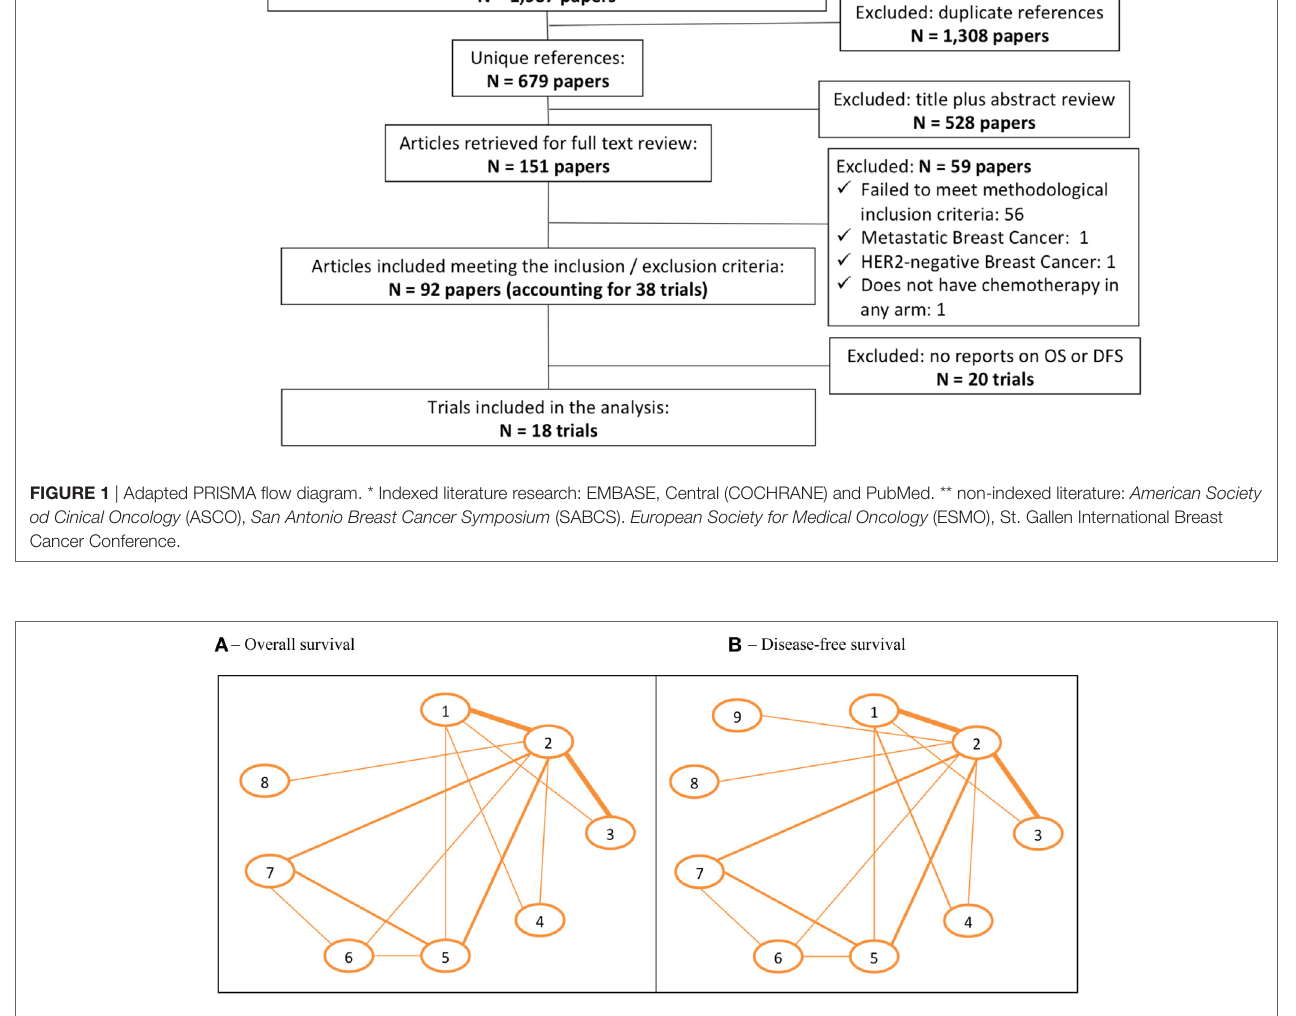
FiGURe 2 | Networks for overall survival (OS) and disease-free survival (DFS). (A) OS. (B) DFS. The width of the lines represents the relative weight of the direct evidence for a given comparison, based on the number of patients included in trials. ARM 1, chemotherapy alone. ARM 2, chemotherapy + trastuzumab 12 months. ARM 3, chemotherapy + trastuzumab ≤ 6 months. ARM 4, chemotherapy (taxane + carboplatin) + trastuzumab 12 months. ARM 5, chemotherapy + lapatinib 12 months. ARM 6, chemotherapy + trastuzumab 3 months  lapatinib 9 months (sequential to trastuzumab). ARM 7, chemotherapy + trastuzumab 12 months + lapatinib (concomitant with trastuzumab). ARM 8, chemotherapy + trastuzumab 12 months + pertuzumab (concomitant with trastuzumab). ARM 9, chemotherapy + trastuzumab 12 months  NERATINIB 12 months (sequential to trastuzumab).